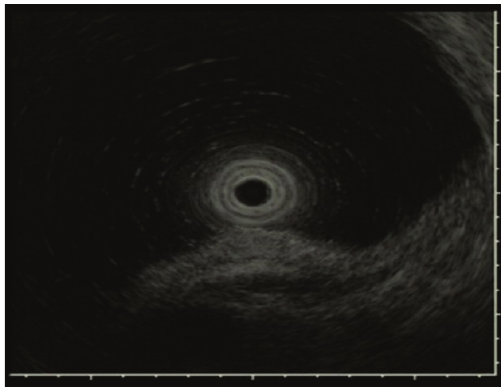
Figure 3: EUS image of the lesion of Figure 2. EUS showing no hypoechoic area suggestive of blood vessels in the third layer.